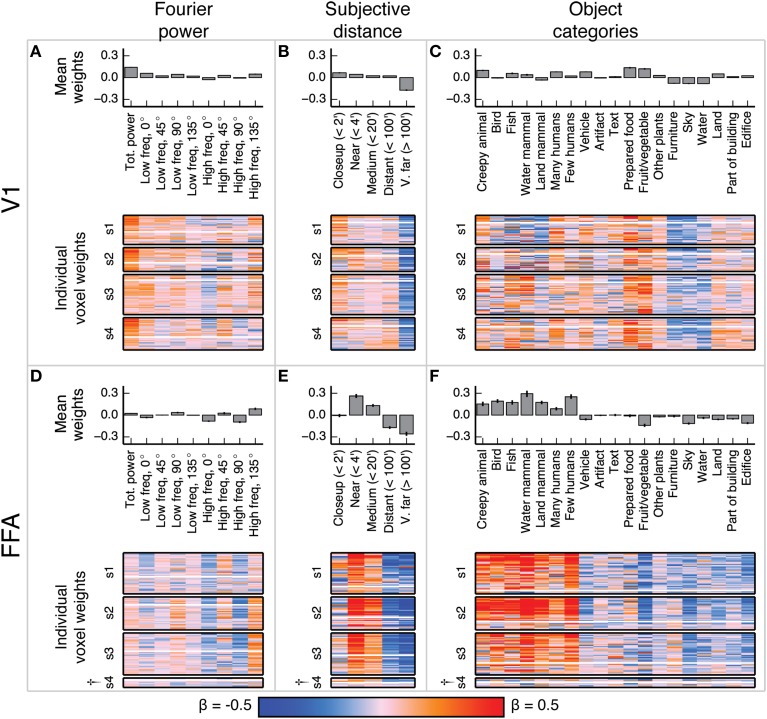
Voxel-wise model β weights for all models for all voxels in V1 and FFA. (A) Model β weights for the Fourier power model for V1. The image in the lower part of the panel shows the weight for every voxel in V1 that met our selection criterion [γ > 0.04, p(γ) < 0.01, see Methods]. Voxels are separated by subject (s1–s4), and the relative size of each subject's section indicates the relative number of voxels selected in V1 for that subject. † marks indicate specific ROIs in specific subjects with low signal quality (and thus few voxels selected for analysis). See Figure S01 for evaluation of signal across subjects. Each horizontal stripe through the image shows the weights for a different voxel. Voxels are sorted within each subject by normalized prediction accuracy for the Fourier power model. Weights from the model that produced the most accurate predictions in V1 are at the top. The solid white line across the image for each subject shows the chance threshold for prediction accuracy (p < 0.05, FDR corrected). The bar graph at the top of the panel shows the mean β weights for all V1 voxels for all subjects. Each text label corresponds to both the bar above it and the column of weights below it. Error bars are 99% confidence intervals across all voxels. These tuning patterns are consistent with known response properties of V1, where voxel responses are related to the amount of Fourier power in each image. (B) Same plots as (A), for the subjective distance model in V1. Voxels are sorted by normalized prediction accuracy for the subjective distance model. (C) Same plots as (A), for the object category model in V1. Voxels are sorted by normalized prediction accuracy for the object category model. (D–F) Same plots as (A–C), but for FFA. These tuning patterns are consistent with known response properties of FFA, where voxel responses are related to object categories associated with animate entities.